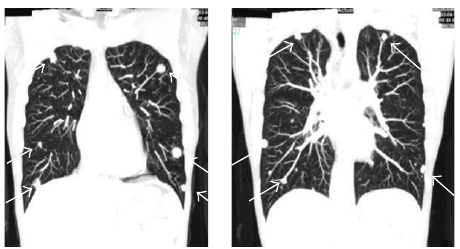
Figure 3: CT scan 3 months later reported multiple pulmonary nodules (arrows) that remain in number and dimension in relation to the previous CT.